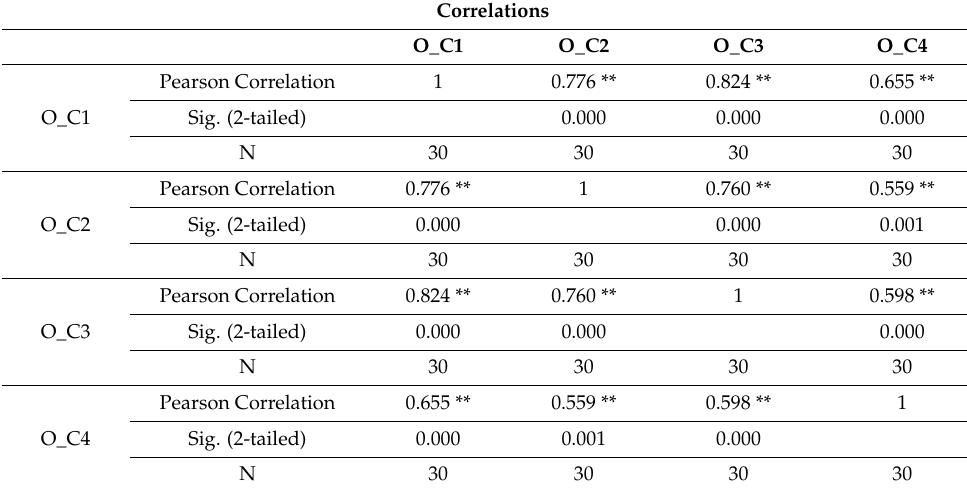
Table 7. Correlation test on occupancy value of red box